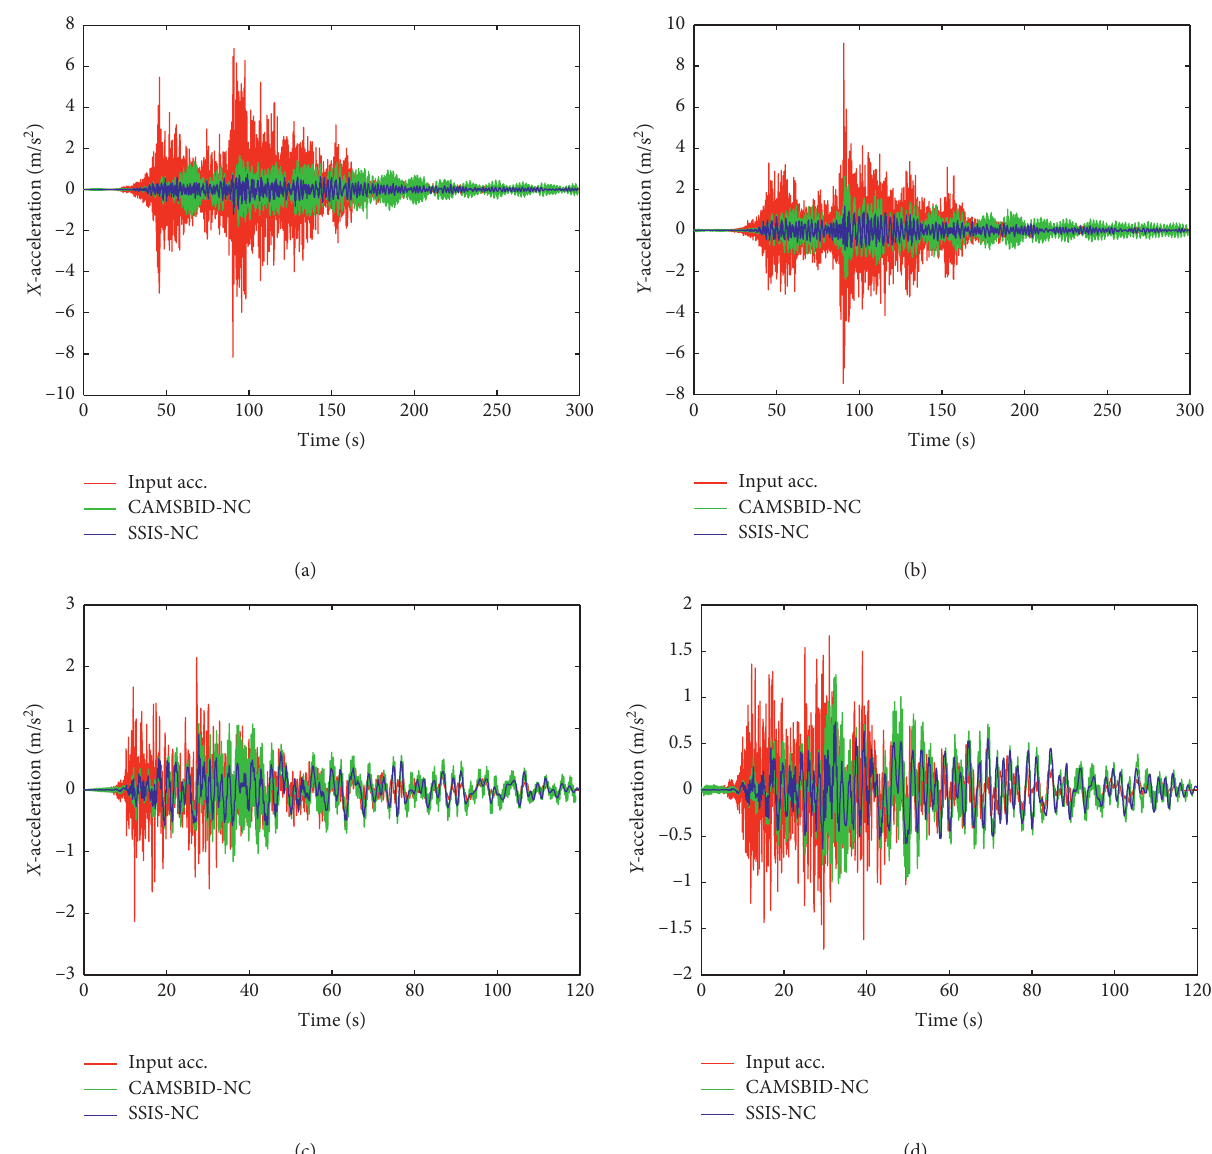
Figure 8: Base-level acceleration responses of SSIS-NC (blue) in comparison with CAMSBID-NC (green) and input acceleration (red) under the effect of 2011 Tohoku (a, b) and 2010 El Mayor (c, d)